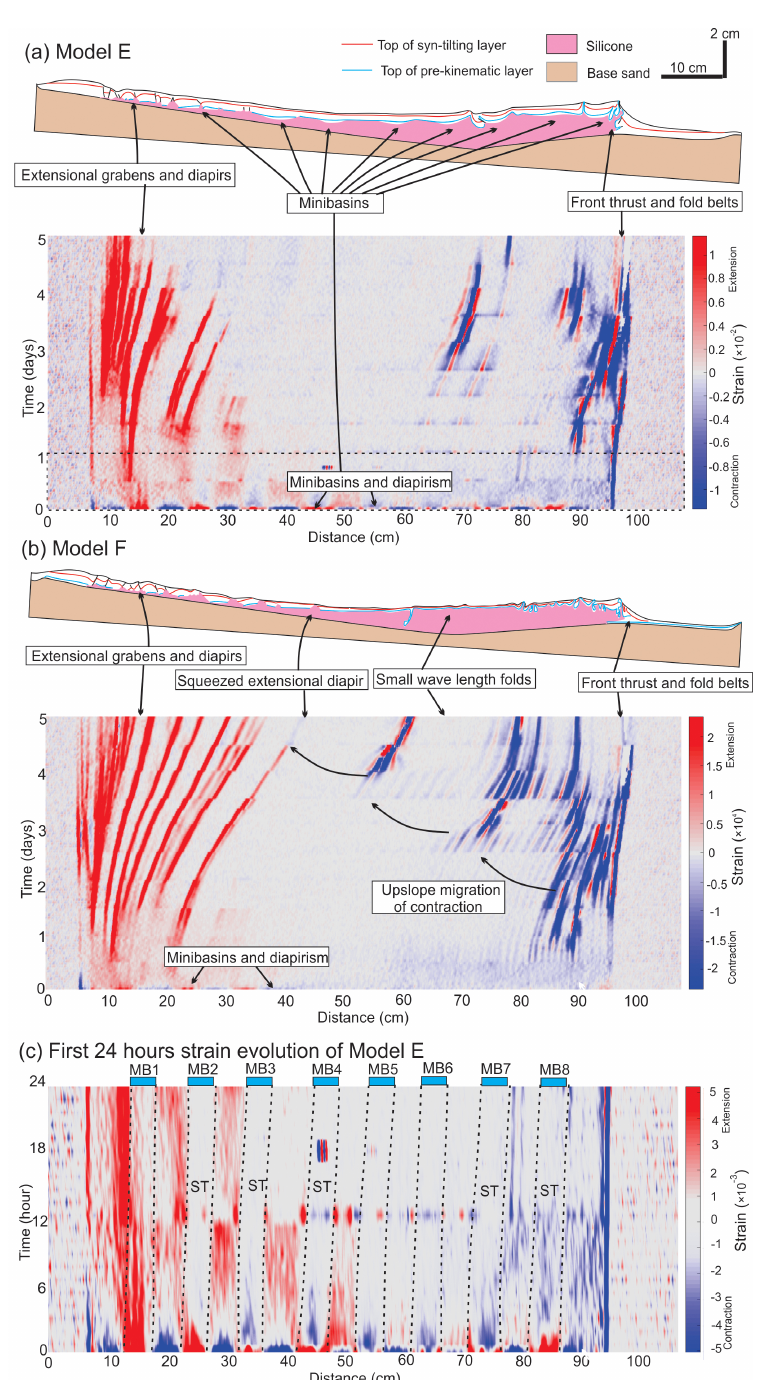
Figure 9. (a) Structural styles and kinematic domain partition in central section of Model E. The strain evolution diagram (showing incremen- tal strain at 1h intervals, or strain rate in 1/h) along the central section beneath shows the initiation of extensional and contractional structures and how they evolve through time. Note the early stage minibasin formation and diapirism and their imprints in the translational domain area. (b) Structural styles and kinematic domain partition in central section of Model F. The strain evolution diagram (showing incremental strain at 1h intervals, or strain rate in 1/h) along the central section reveals the evolution of extensional and contractional structures. Note the early stage diapirism and upslope migration of contraction overprint the translational domain together. (c) Zoom into the strain evolution diagram for the first 24h along central cross section of Model E. The minibasins gradually change from areas of extension to zones that are relatively strong and stable in the first 3h. MB means minibasin and ST means strain transfer. See the dashed box in (a) for the time interval of the zoomed strain